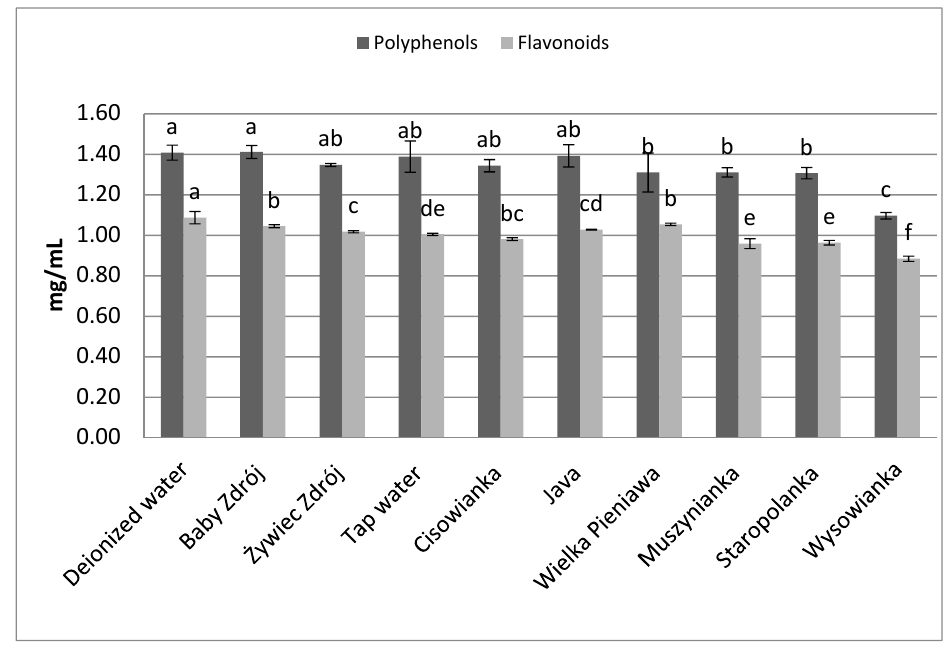
Figure 4. The effect of water mineralization on the extraction of active substances from leaves of peppermint. Data are shown as mean ± SD. Different letters (a, b, c, etc.) show a significant difference with p < 0.05. The differences relate to each group of compounds separately.